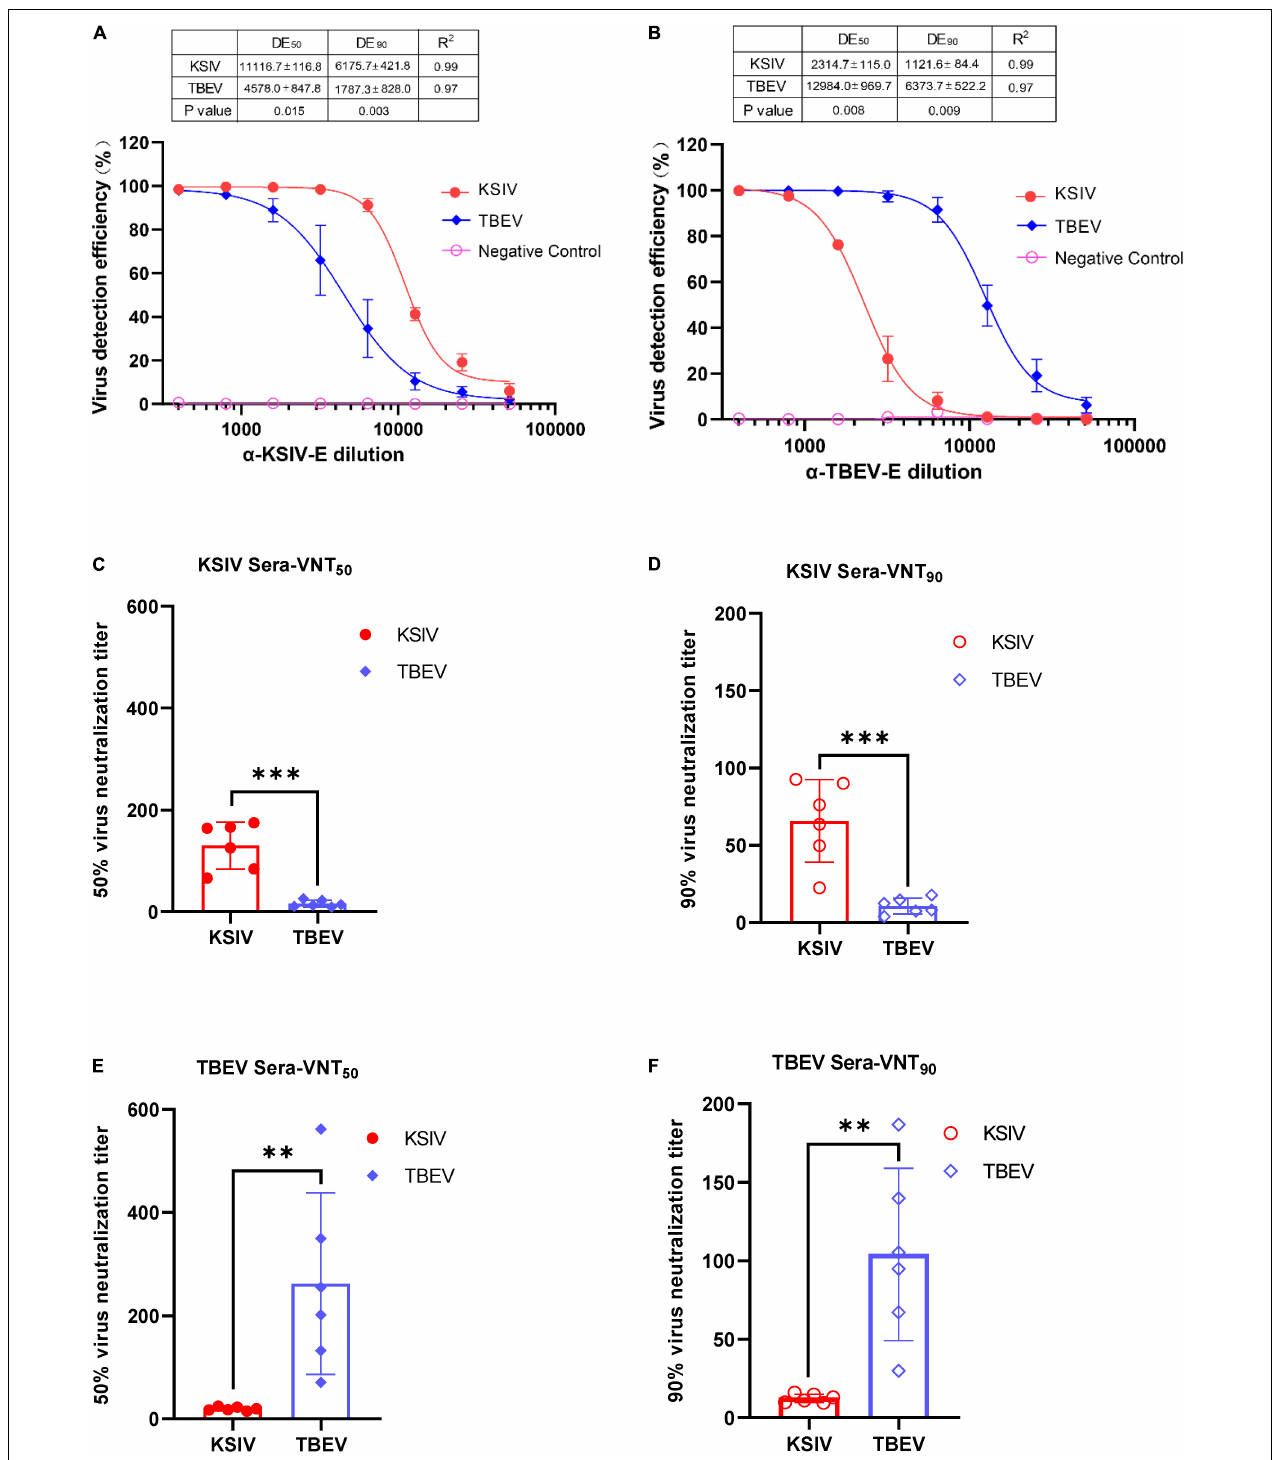
FIGURE 5 | Karshi virus has serological cross-reactivity with TBEV. The determination of KSIV and TBEV serological cross-reaction and neutralization was based on the immunofluorescence test. Percentages of KSIV-infected/TBEV-infected cells were obtained and normalized with the Operetta High-Content Imaging System (PerkinElmer). KSIV and TBEV serological cross-reaction test. The efficiencies of the lab-prepared polyclonal antibodies α -KSIV-E (A) and α -TBEV-E (B) reacting to the KSIV- and TBEV-infected cells were evaluated using GraphPad Prism software (Version 8) least square fitting method to determine the detection efficiency curve. The KSIV-infected mouse serum dilution was determined as an antibody titer that inhibited 50% (C) and 90% (D) of KSIV and TBEV infection. The TBEV-infected mouse serum dilution was determined as an antibody titer that inhibited 50% (E) and 90% (F) of KSIV and TBEV infection. The data were shown as means ± SD. ∗∗ p < 0.01, ∗∗∗ p <